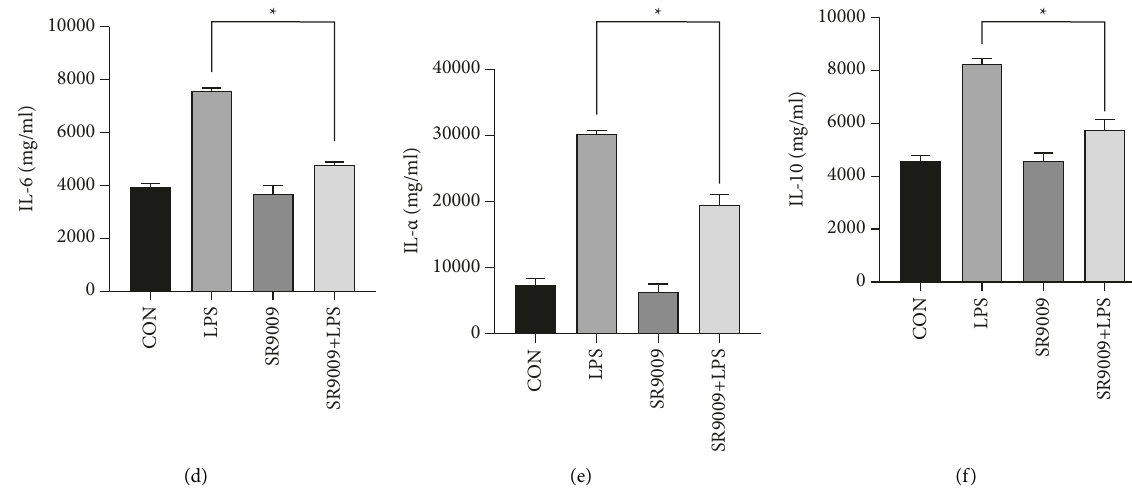
Figure 7: SR9009 alleviates sepsis-induced lung inflammation in mice: (a)–(c) the expression levels of IL-6, TNF- α , and IL-10 in lung tissues were detected by ELISA assay and (d)–(f) the expression level of IL-6, TNF- α , and IL-10 in serum were detected by ELISA assay. ∗ p < 0 .